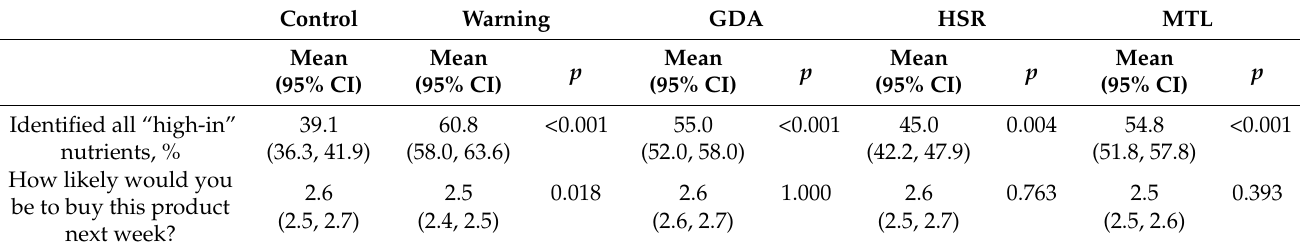
Table A7. Sensitivity results for the primary outcomes using non-clustered standard errors ( n = 14,345).